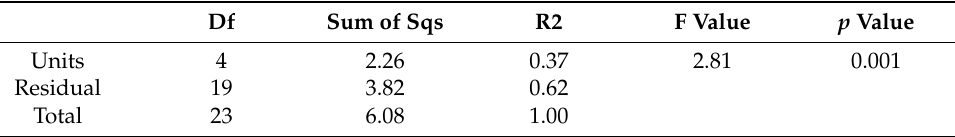
Table 1. Estimation of fungal beta-diversity by multivariate Permutation test for adonis (n. permutation 999) under reduced model of the different permafrost units (U).